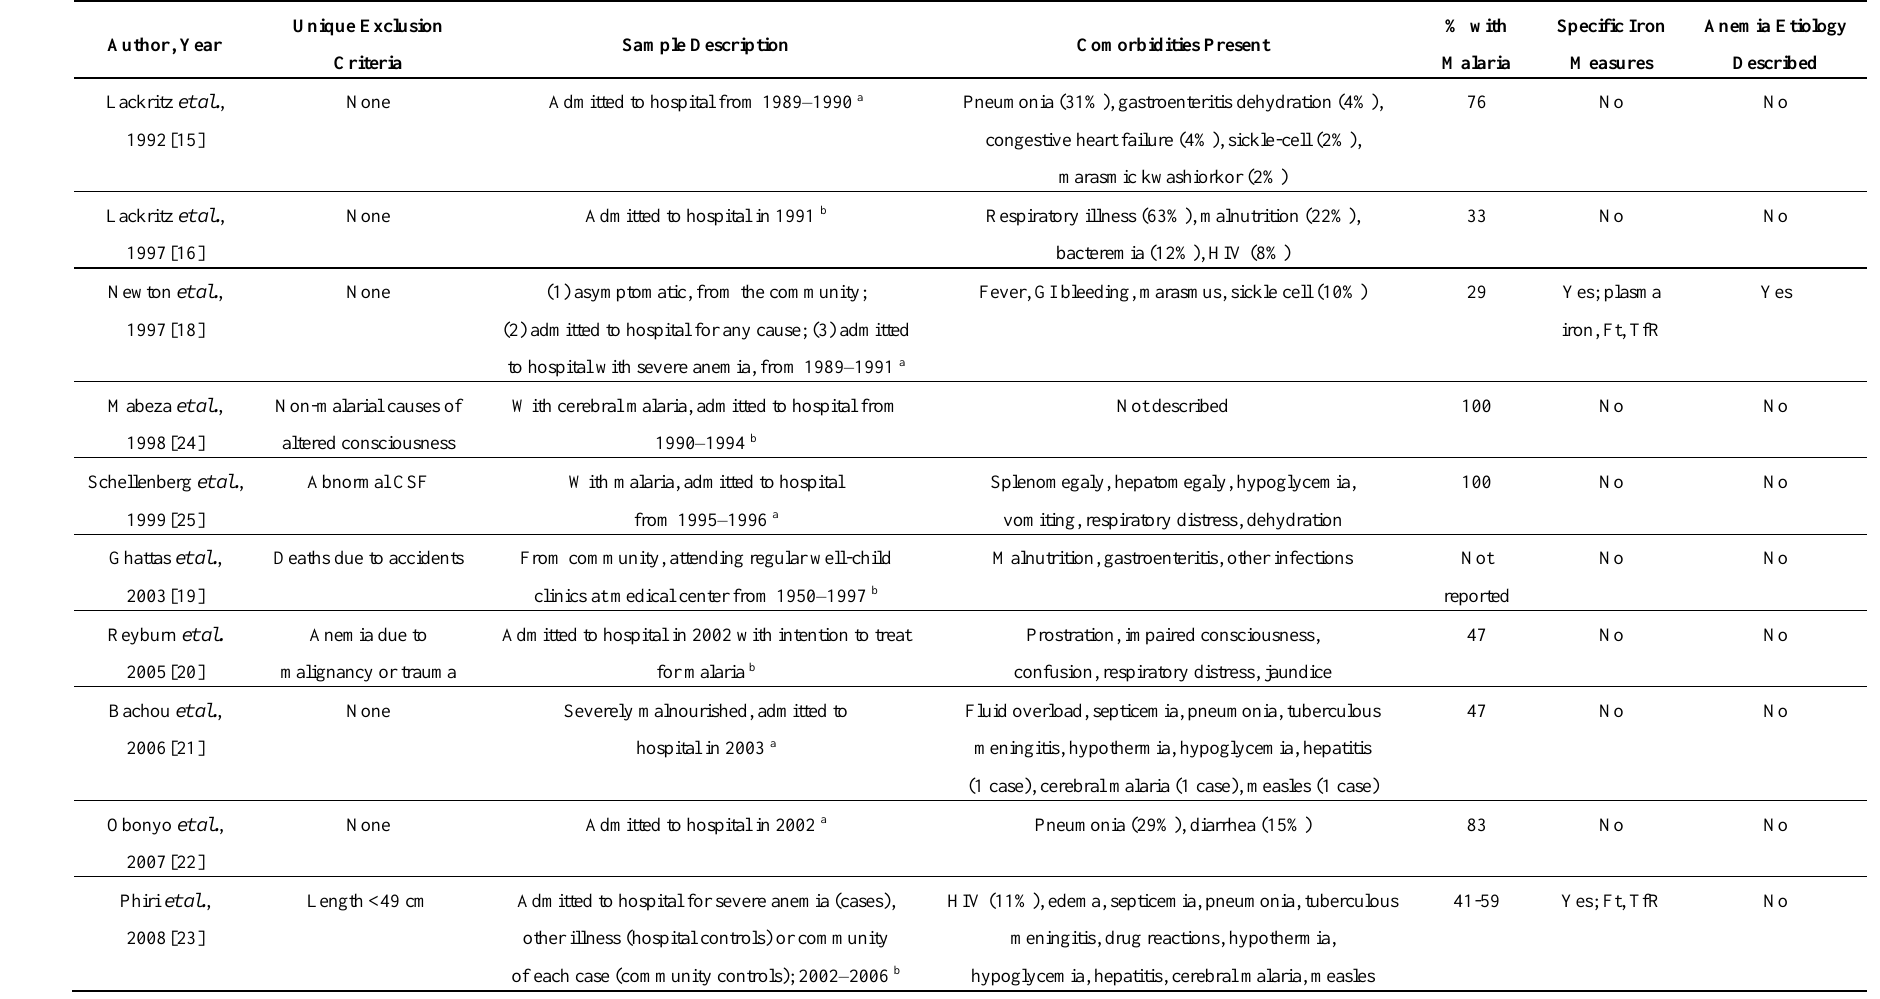
Table 2. Additional characteristics of the included